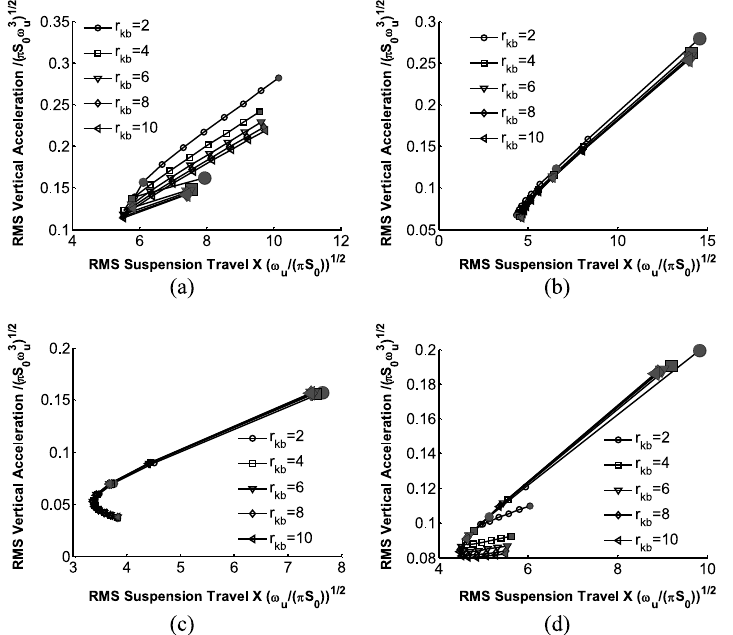
Fig. 12. Relationship between RMS acceleration and RMS suspension travel with layout s8 (effect of centering spring k b and damping): (a) Passive; (b) Groundhook; (c) Hybrid; (d) Skyhook.